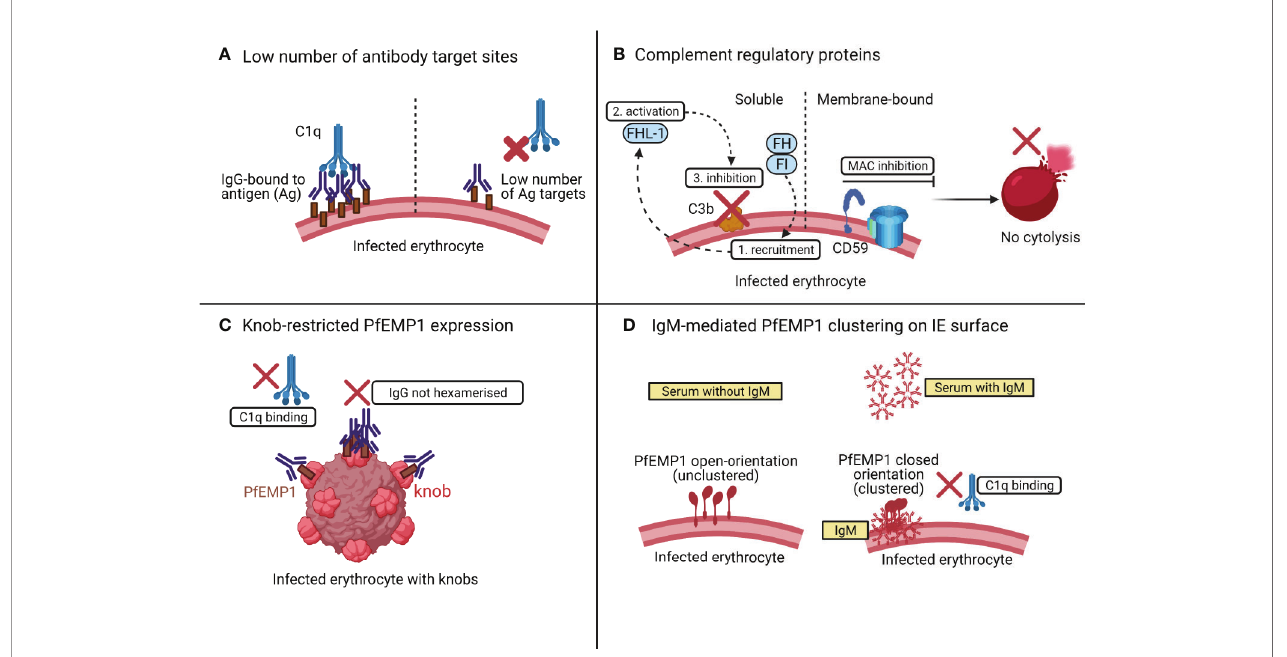
FIGURE 4 | Possible mechanisms of resistance of IEs to classical complement attack. As shown in (A) , if the number of PfEMP1 target sites on IEs are below a certain threshold level, complement is not activated even in the presence of an ample supply of antibody and complement. In (B) , the presence of complement regulatory proteins such as the membrane bound CD59, inhibits the MAC assembly, to prevent lysis of IEs. The soluble complement regulatory factors [factor I (FI) and factor H (FH)] are also recruited onto the schizont surface (1) and activate FH-like protein 1 (FHL-1) (2) to prevent C3b deposition (3) on the schizont